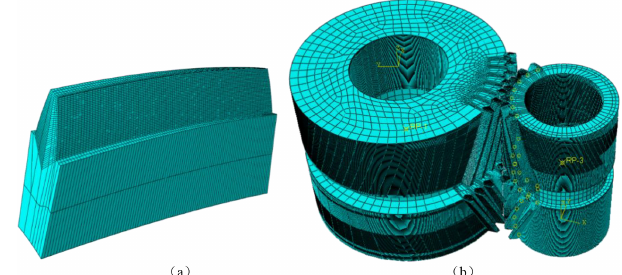
Figure 9. The finite element models. (a) Meshing of single gear teeth. (b) Meshing of the herringbone gear system. Table 1. Design data of the herringbone gear drive represented in Fig.